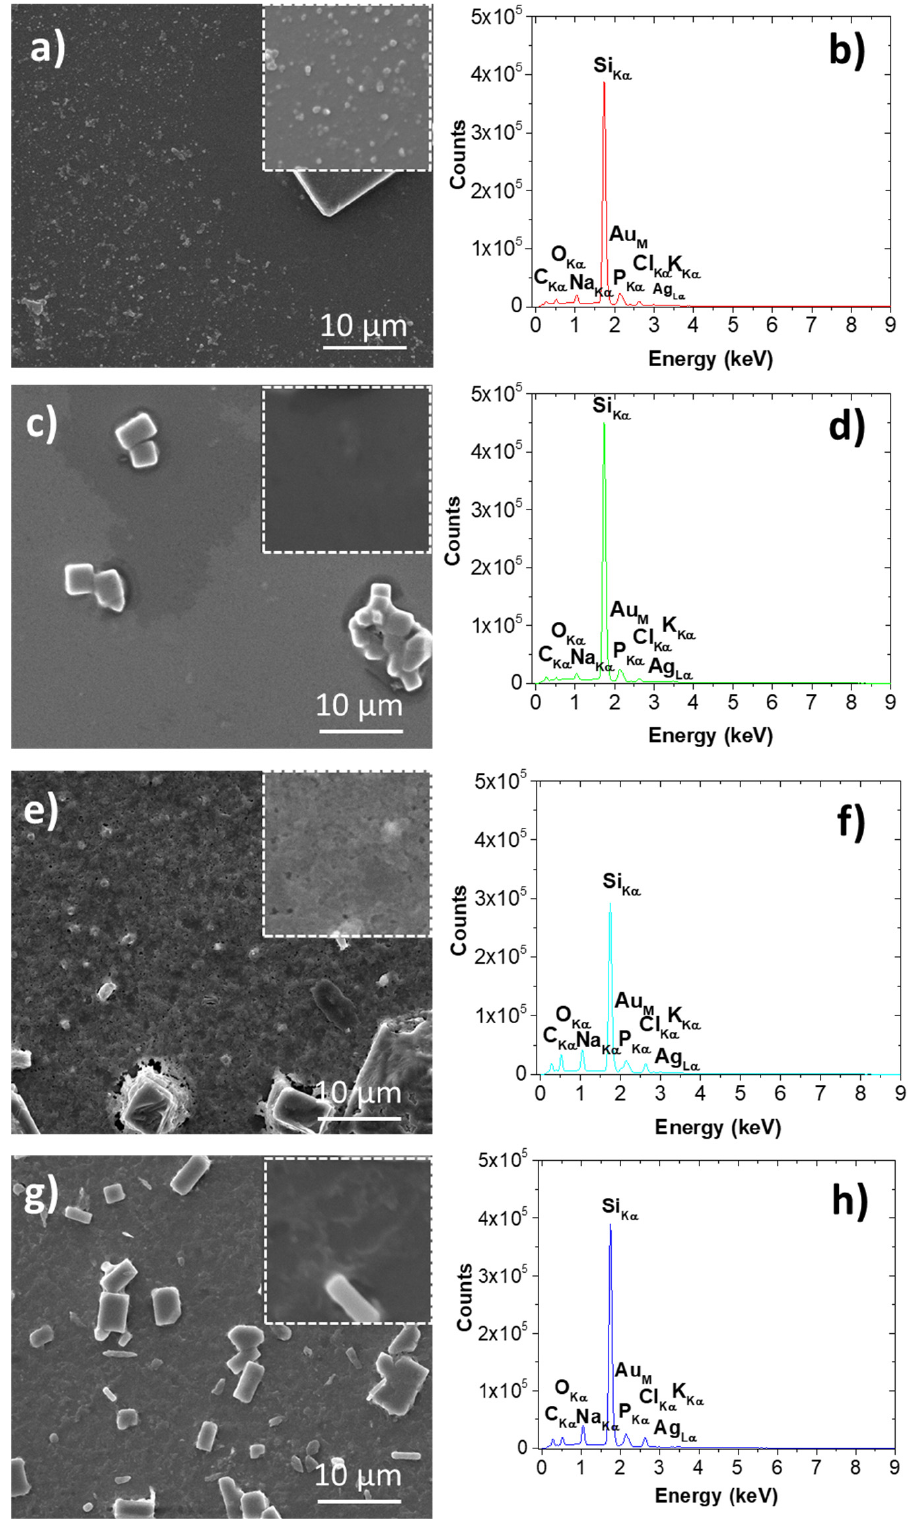
Figure 6. Left column presents SEM results ( a , c , e , g ) and right column shows EDS results (spectra b , d , f , h ) for samples, from top to bottom: Tur-nAg/AgCl, Tur-nAg/AgCl-Lip, Tur-nAg/AgCl-CTS and Tur-nAg/AgCl-Lip-CTS. Magnified SEM images of 5 × 5 µ m 2 are also